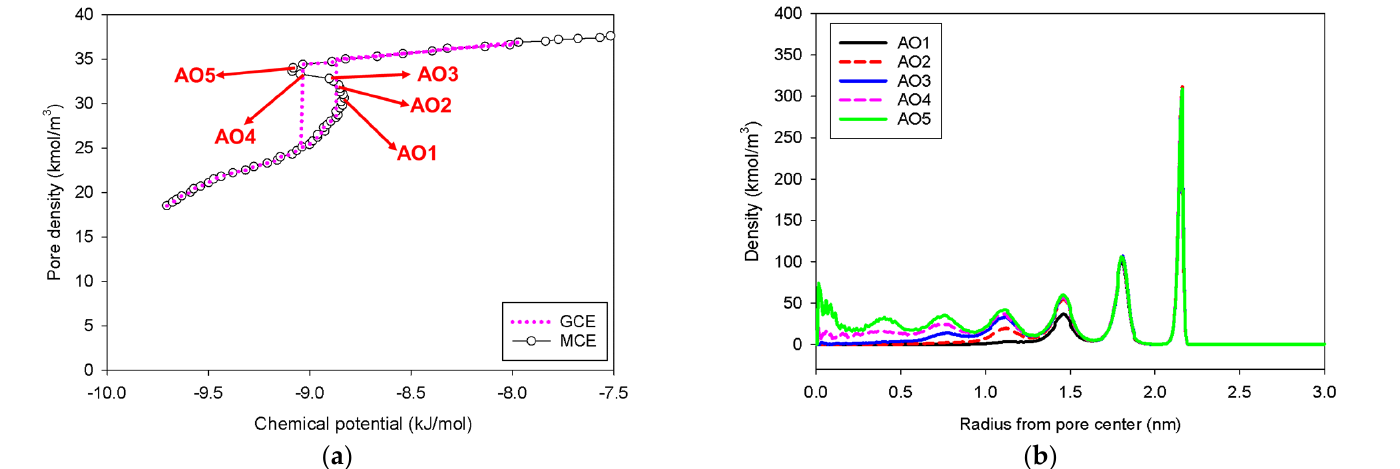
Figure 10. ( a ) Nitrogen adsorption isotherm in the spherical pore of 5 nm in diameter at 77 K, and ( b ) its local density distributions across pore radius.